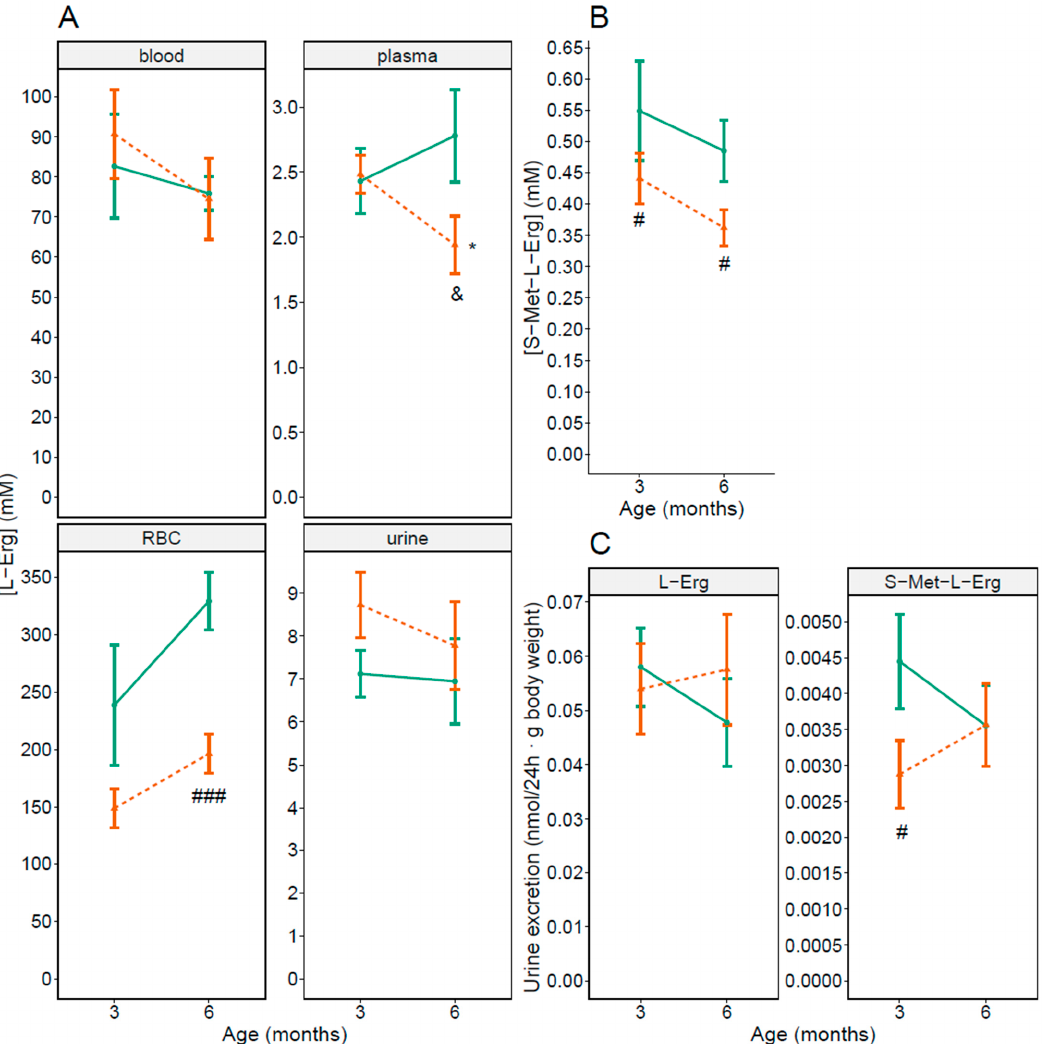
Figure 2. L-Erg and S-Met-L-Erg levels in WT and cystinuric ( Slc7a9 − / − ) female mice at 3 and 6 months of age. ( A ) L-Erg concentration in blood, plasma, red blood cells (RBC) and 24 h urine in WT (green solid line) and Slc7a9 − / − (orange dashed line) female mice. ( B ) S-Met-L-Erg concentration in 24 h urine. ( C ) L-Erg and S-Met-L-Erg excretion. Mean ± SEM are shown in all panels and Mann-Whitney probability test value is indicated as *, p ≤ 0.05 vs . 3 months of age; and &, p ≤ 0.1, #, p ≤ 0.05 and ###, p ≤ 0.001 vs . WT mice. The number of independent mice used per condition ranges from 6 to 31.